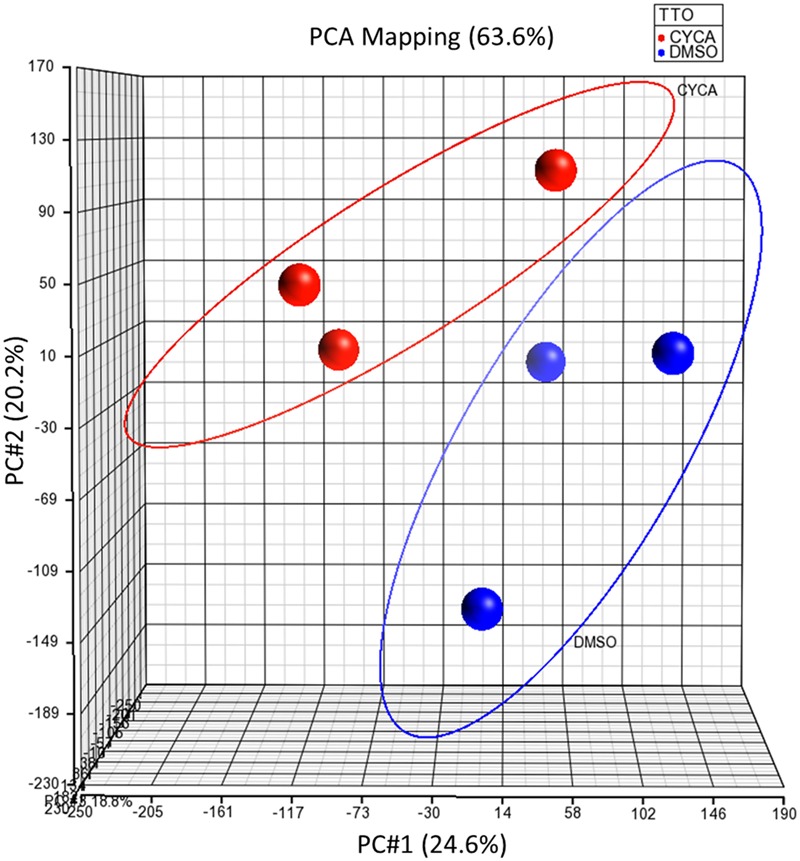
Unsupervised PCA of global miRNA expression profiling separates CYCA treated cells from control cells. HepG2 cultures were incubated for 24 h with CYCA (25 μM CYCA) or solvent (0.05% DMSO). miRNA expression profiles were analyzed by Affymetrix GeneChip miRNA Arrays. PCA was performed with the Partek Genomics Suite.